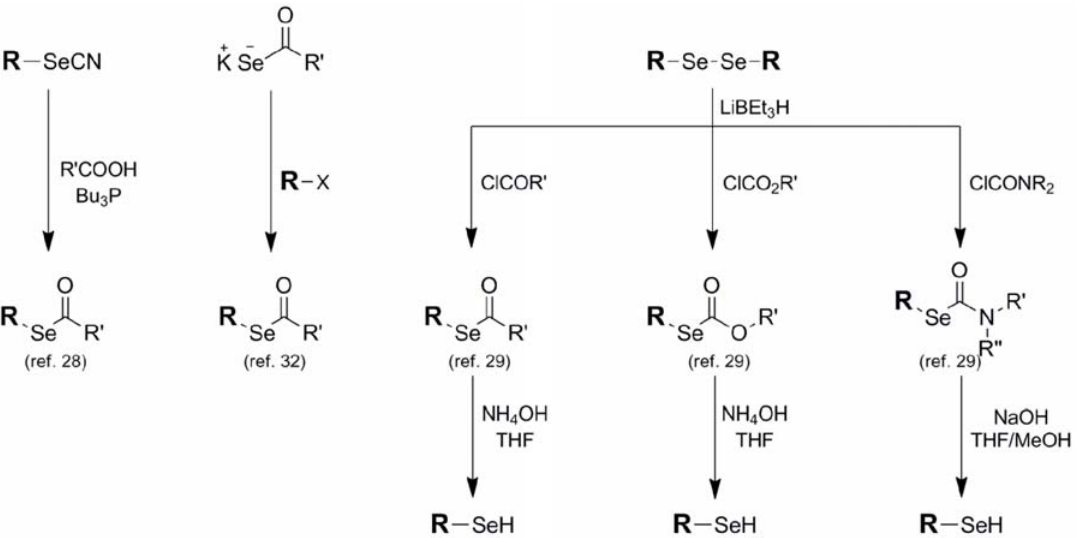
Figure 6. Synthesis and deprotection conditions for selenoacetates, selenocarbonates, and